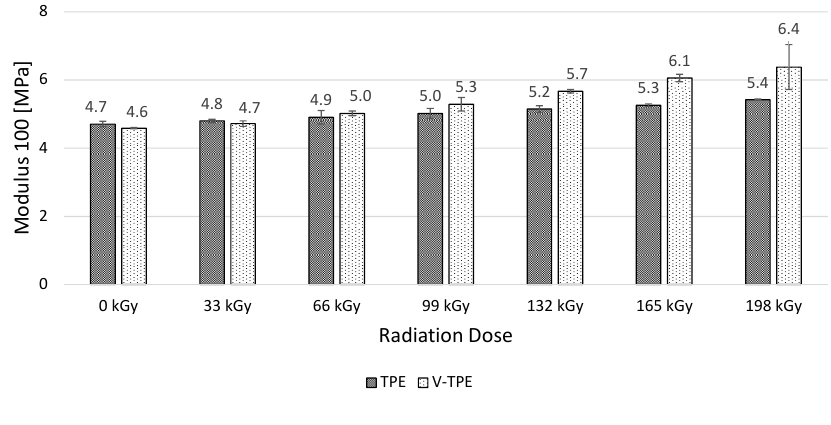
Figure 12. Modulus 100—TPE, V-TPE.